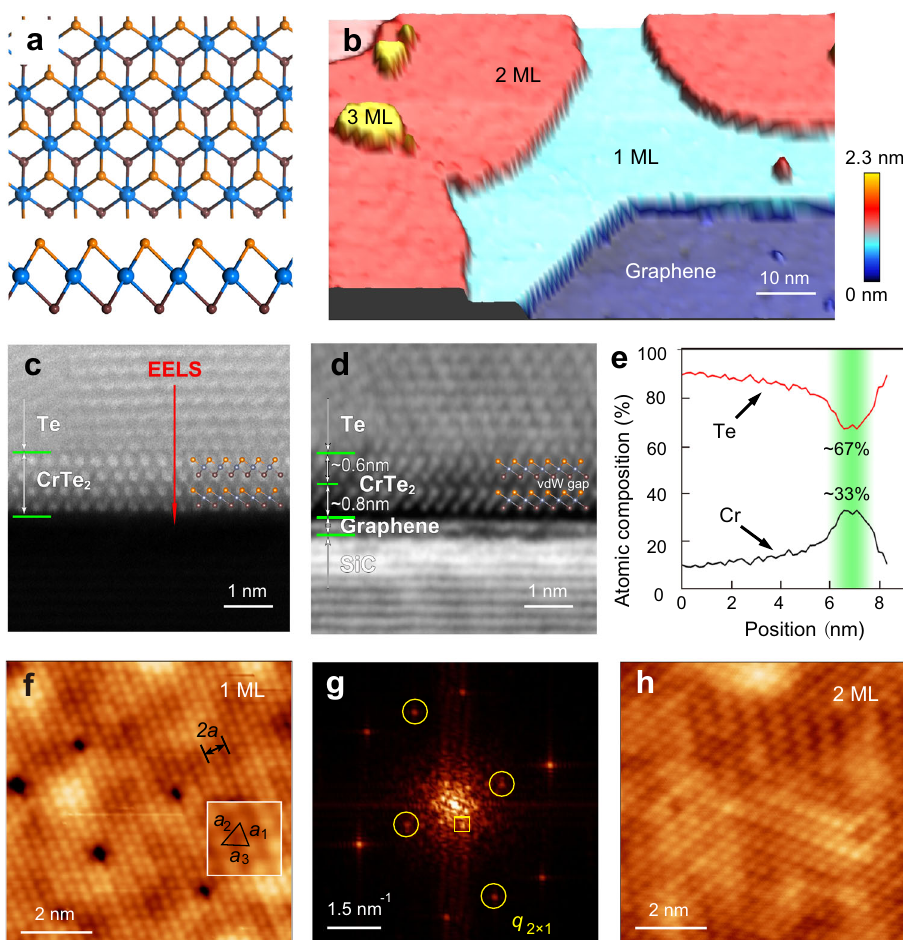
Fig. 1 Morphology of 1T-CrTe 2 fi lms. a Top view (up) and side view (down) of the crystal structure of 1T-CrTe 2 . The orange (brown) balls represent the top (bottom) Te atoms, and the dodger-blue balls represent the Cr atoms. b Pseudo-3D topographic STM image ( V b = 2 V, I t = 10 pA) of CrTe 2 fi lms. The thicknesses of the fi lms are marked. c , d Atomic resolution of the HAADF-STEM ( c ) and iDPC images ( d ) of the side view of 2 ML CrTe 2 . e EELS quanti fi cation analysis along the red line in c , demonstrating that the chemical stoichiometry of Cr and Te is 1:2 at the green-shaded region. f , g Atomic resolution of the STM image ( V b = 0.1 V, I t = 85 pA) of 1 ML CrTe 2 ( f ) and its FFT image ( g ). Inset of ( f ) shows a zoomed-in view (1 × 1 nm 2 ) of the ML CrTe 2 . The periodicity of the 2 × 1 structure is marked. The yellow circles in ( g ) mark the 2 × 1 superstructure of the Te lattice. h Atomic resolution of the STM image ( V b = − 25 mV, I t = 10 pA) of 2 ML CrTe 2